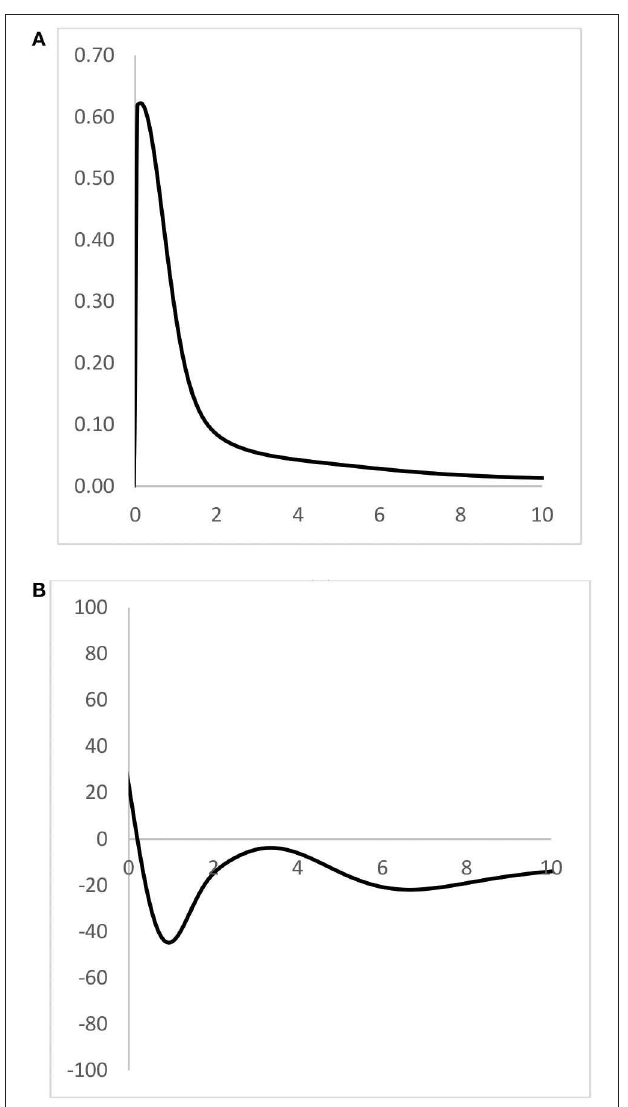
FIGURE 4 | Comparison of the ergodic distributions and MPPs of the coal market for all countries across time. Note: For (A) , horizontal axis represents relative per capita consumption, vertical axis represents proportion. For (B) , horizontal axis represents relative per capita consumption, vertical axis represents MPP. Source: Authors’